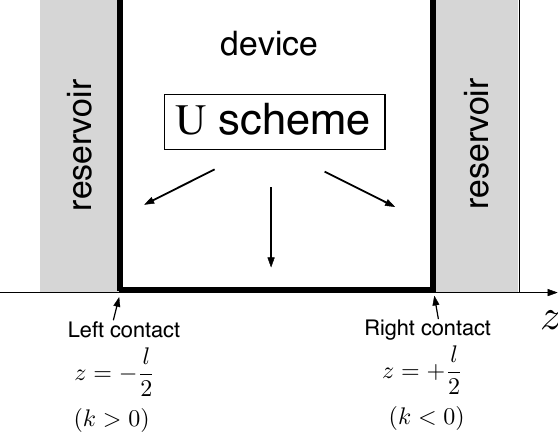
Figure 2. The conventional inflow or U boundary condition scheme adopted in semiclassical device modeling [20] for a one-dimensional problem. The value of the distribution function f ( z , k ) is specified l /2, k > 0 ) and f (+ l /2, k < 0 ) are fixed by the at the boundaries z b ( k ) of the active region, i.e., f ( − incoming/inflowing carrier distribution function. Reprinted from